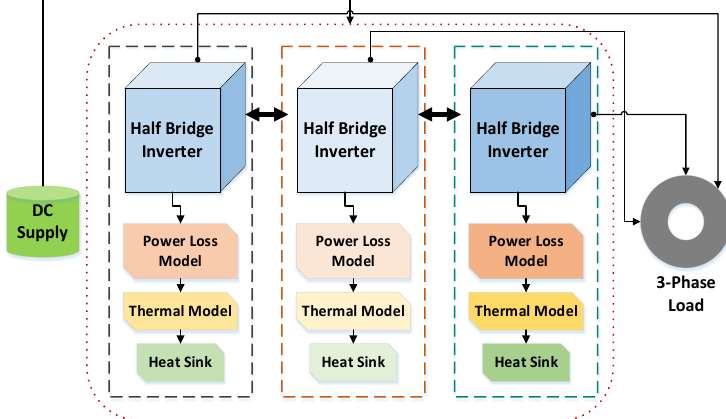
Figure 11. Inverter’s electro-thermal model block diagram.